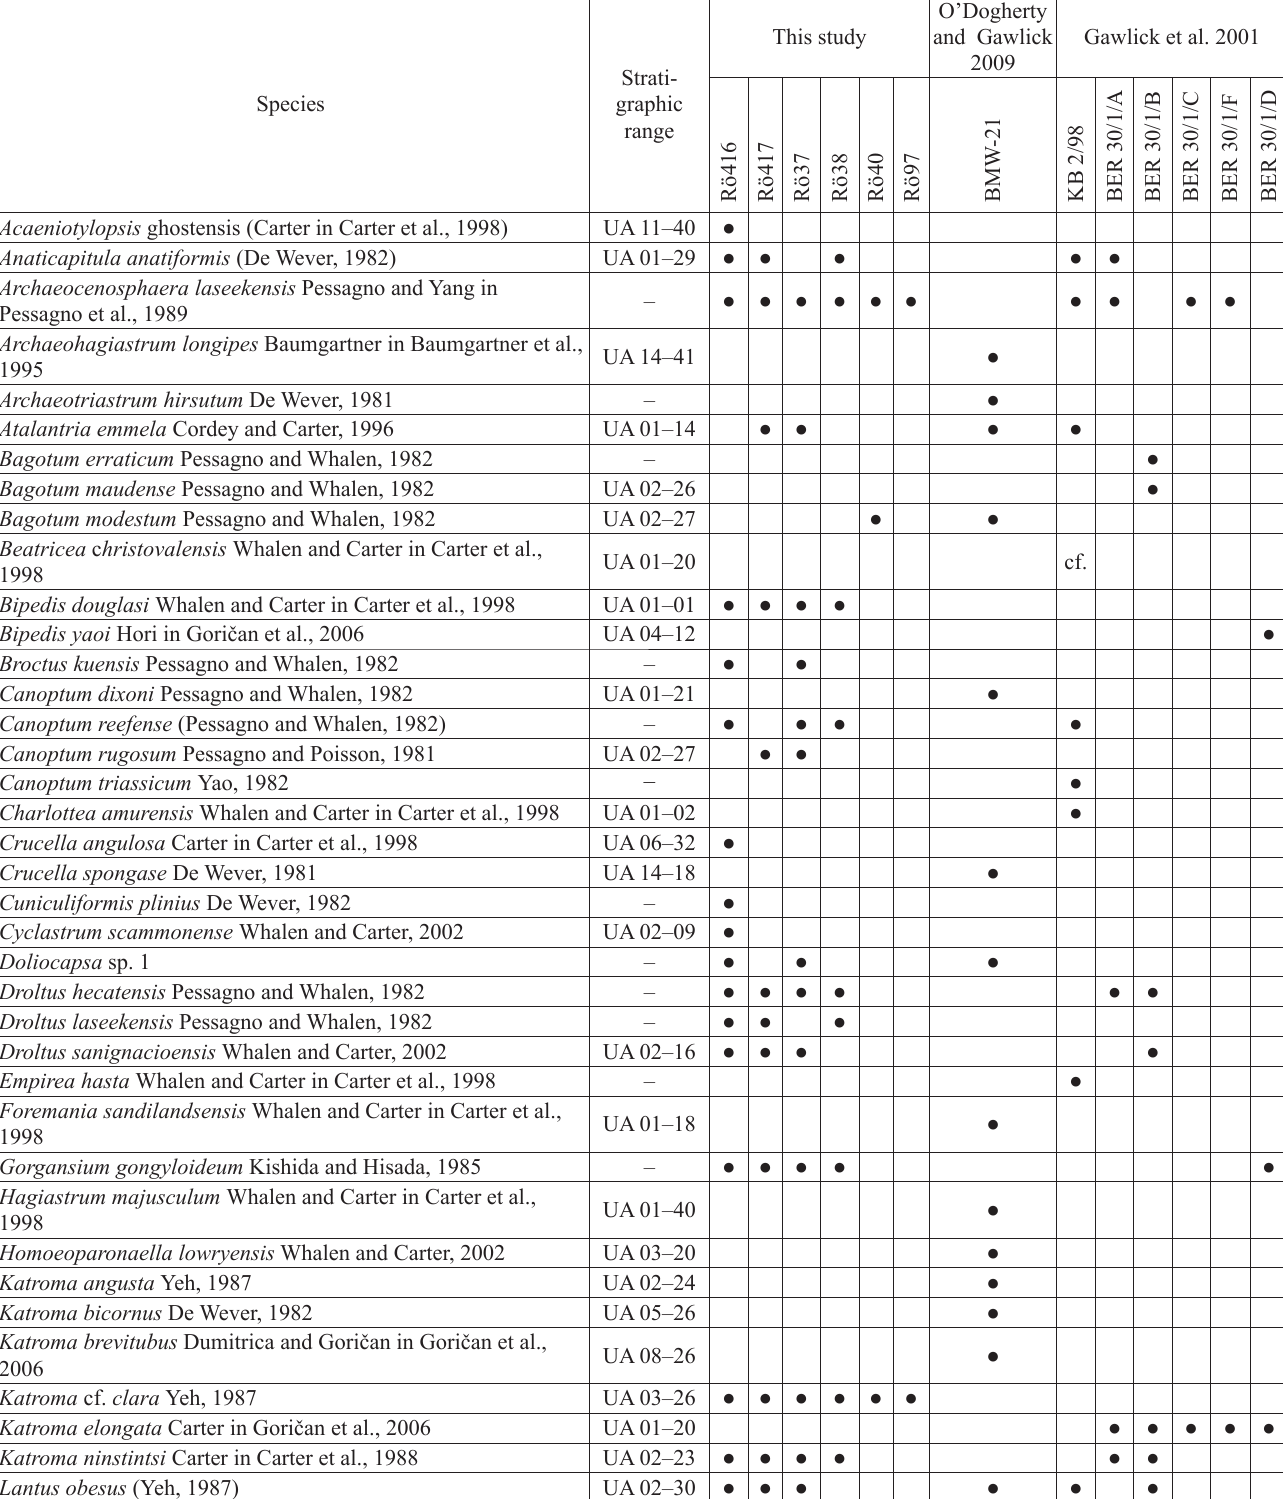
Table 7. Comparison of faunas from Mount Rettenstein and from the Dürrnberg Formation (data from Gawlick et al. 2001; O’Dogherty and Gawlick 2008). Stratigraphic ranges are given according to Carter et al. 2010 (UA Uppermost Sinemurian–Aalenian). All taxa from the Dürrnberg Formation and all age-diagnostic taxa from Mount Rettenstein samples are included. Sample BER 30/1/D is placed in the last column of the table, because it is stratigraphically higher than BER 30/1/F (Gawlick et al. 2001). Sample age: Rö416, Rö37, KB 2/98, BER 30/1/A–D, BER 30/1/F, Canutus tipperi – Katroma clara (UA 02–05) to Zartus mostleri – Pseudoristola megaglobosa (UA 06–09); BMW-21, Gigi fusti – Lantus sixi (UA 12–18; UA 14, according to Carter et al.